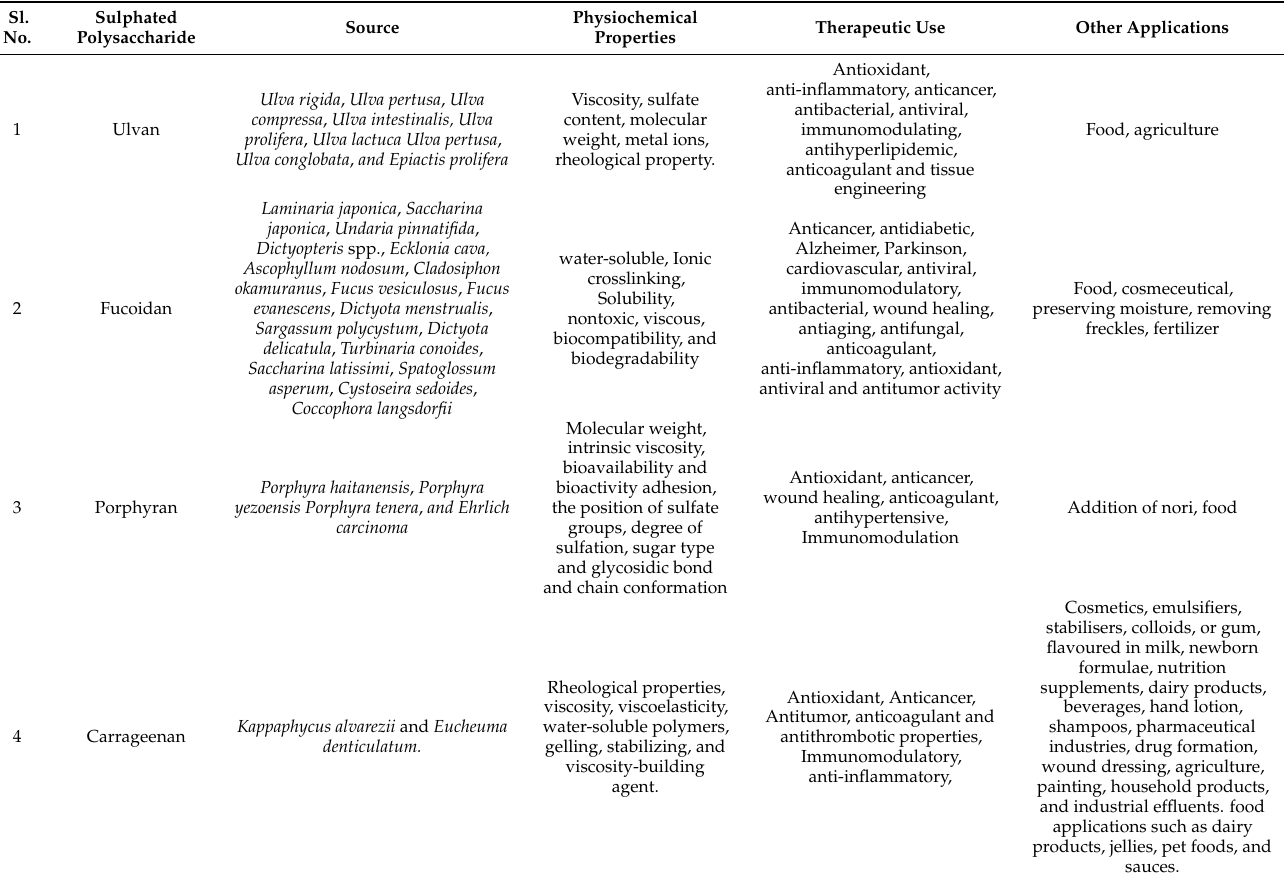
Table 1. The physicochemical characteristics of sulfated polysaccharides and their therapeutic potential with other